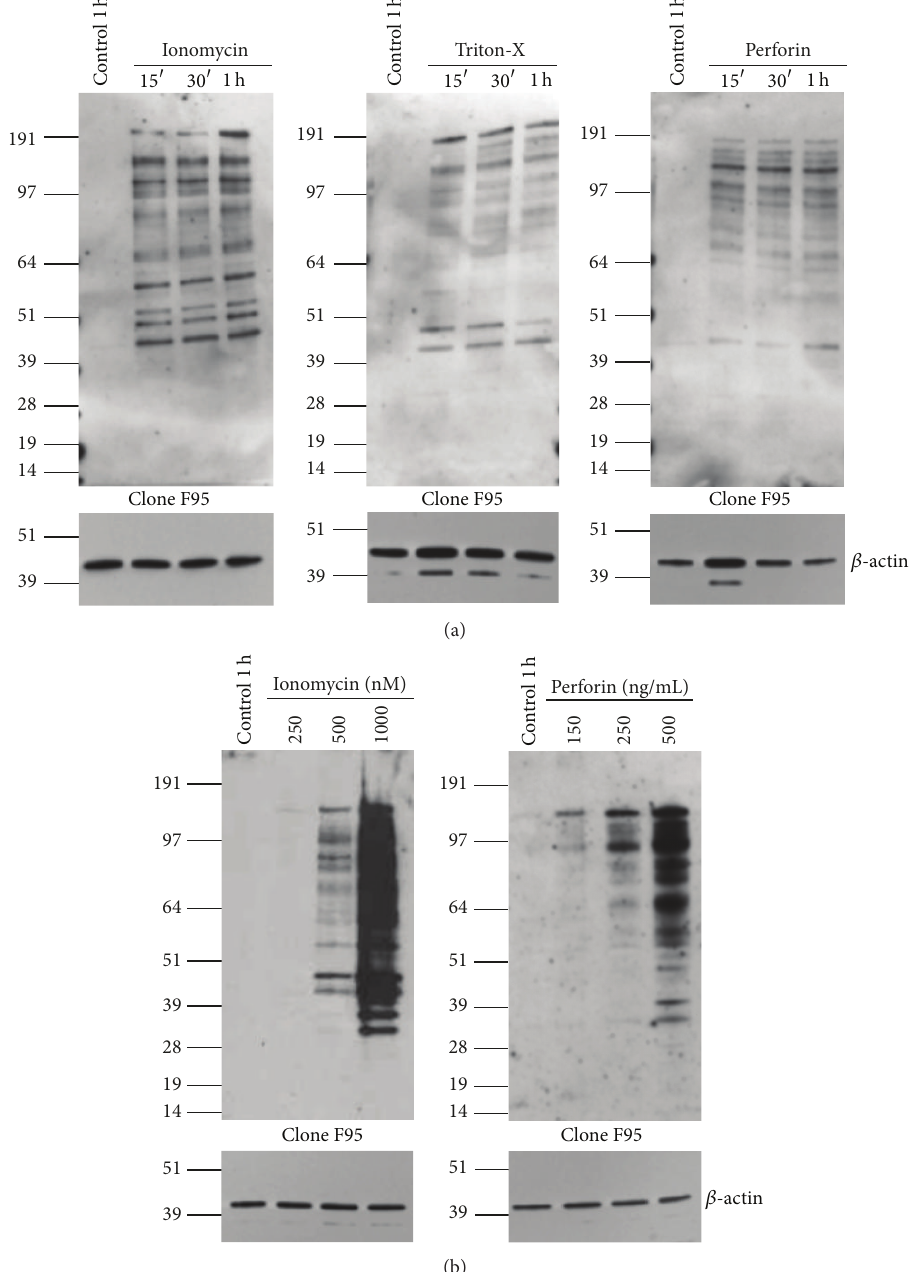
Figure 2: Time-course and dose-response of hypercitrullination in human neutrophils. (a) Isolated neutrophils were cultured in medium with 2 mM CaCl 2 alone or in the presence of 1 𝜇 M ionomycin, 0.005% Triton-X, or 500 ng/mL perforin for the indicated times. Citrullinated proteins were detected by anti-citrulline antibody clone F95 (upper panels) and similar loading of cell lysate was verified with anti- 𝛽 -actin blots of the same filters (lower panels). (b) Isolated neutrophils were cultured in medium with 2 mM CaCl 2 alone for 1h or in the presence of the indicated concentrations of ionomycin or perforin for 30 min (upper panels). Anti- 𝛽 -actin blots of the same filters (lower panels). Results are from one donor representative of three different